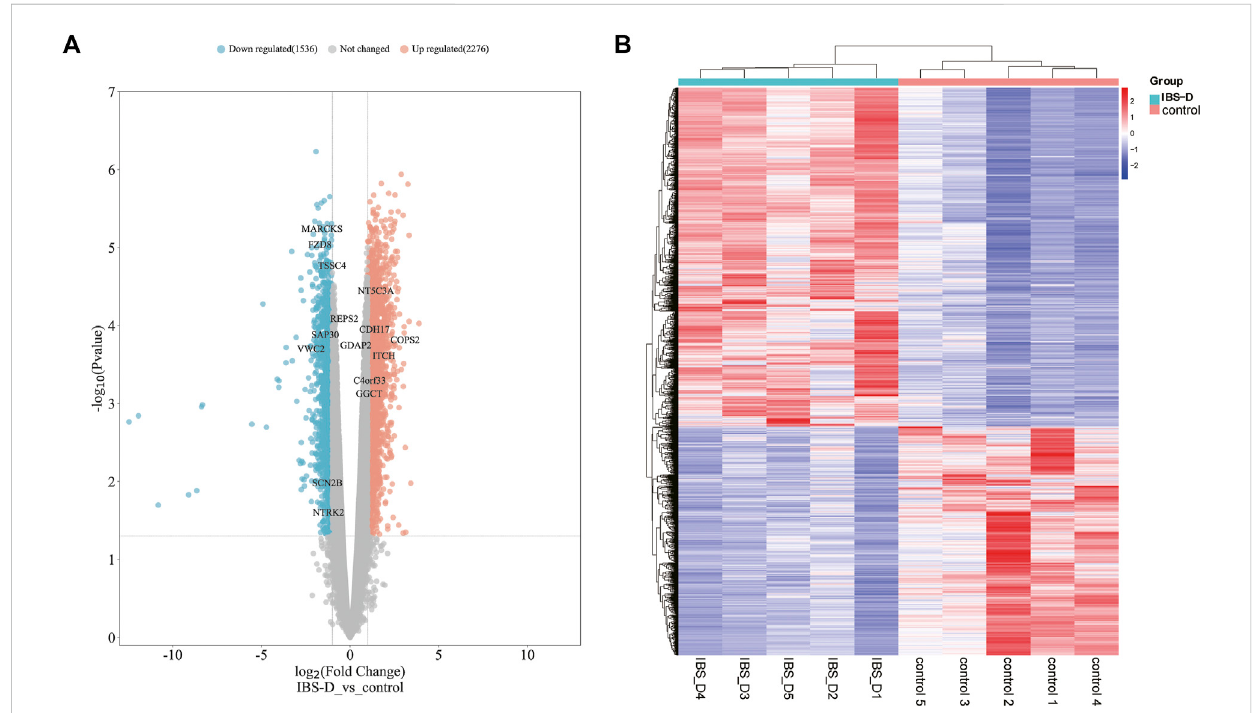
FIGURE 6 Distribution of differential mRNAs. (A) Volcano map of differential mRNAs. Orange indicates the upregulation of genes, cyan indicates the downregulation of genes, and non-differentially expressed genes are shown in grey. (B) Heat map of differential mRNAs. IBS-D group versus control